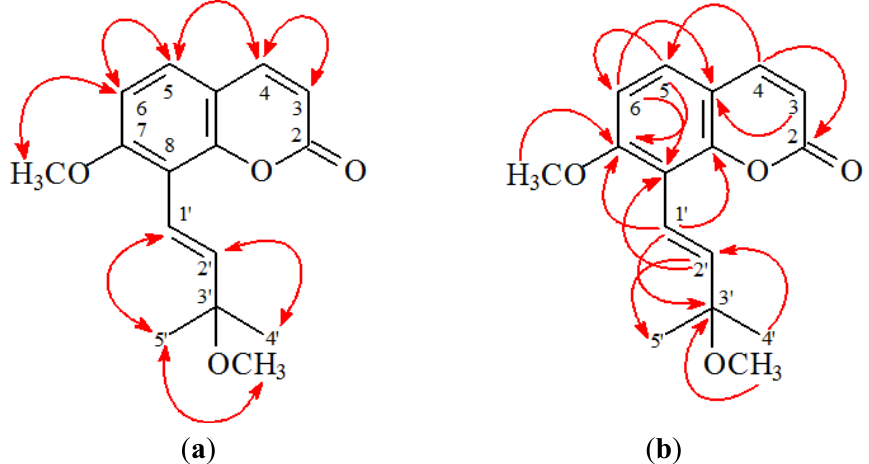
Figure 3. Key NOESY ( a ) and HMBC ( b ) correlations of 1